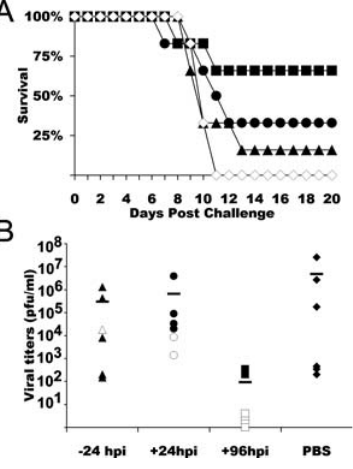
Figure 5. Treatment of Guinea Pigs with Antisense PMOs Increases Survival Following Lethal Ebola Virus Infection Hartley guinea pigs ( n ¼ 6) weighing 400–500 g each were treated intraperitoneally with 10 mg each of VP24, VP35, and L PMO in PBS at (cid:2) 24 (triangle), þ 24 (circle), or þ 96 (square) h post challenge. Control guinea pigs were injected with PBS only (diamond). The guinea pigs were infected subcutaneously with ; 1,000 pfu of EBOV and monitored for illness for 21 d. (A) The data are presented as percent survival for each group. (B) Viral titers in the serum of guinea pigs at 7 d post challenge (dpc). The data are presented as the titers of individual guinea pigs treated with PMOs at (cid:2) 24, þ 24, or þ 96 h post challenge or PBS only and the mean viral titer for each group (horizontal line). Animals which survived are represented by open symbols and those that succumbed to disease are represented by filled symbols. DOI: